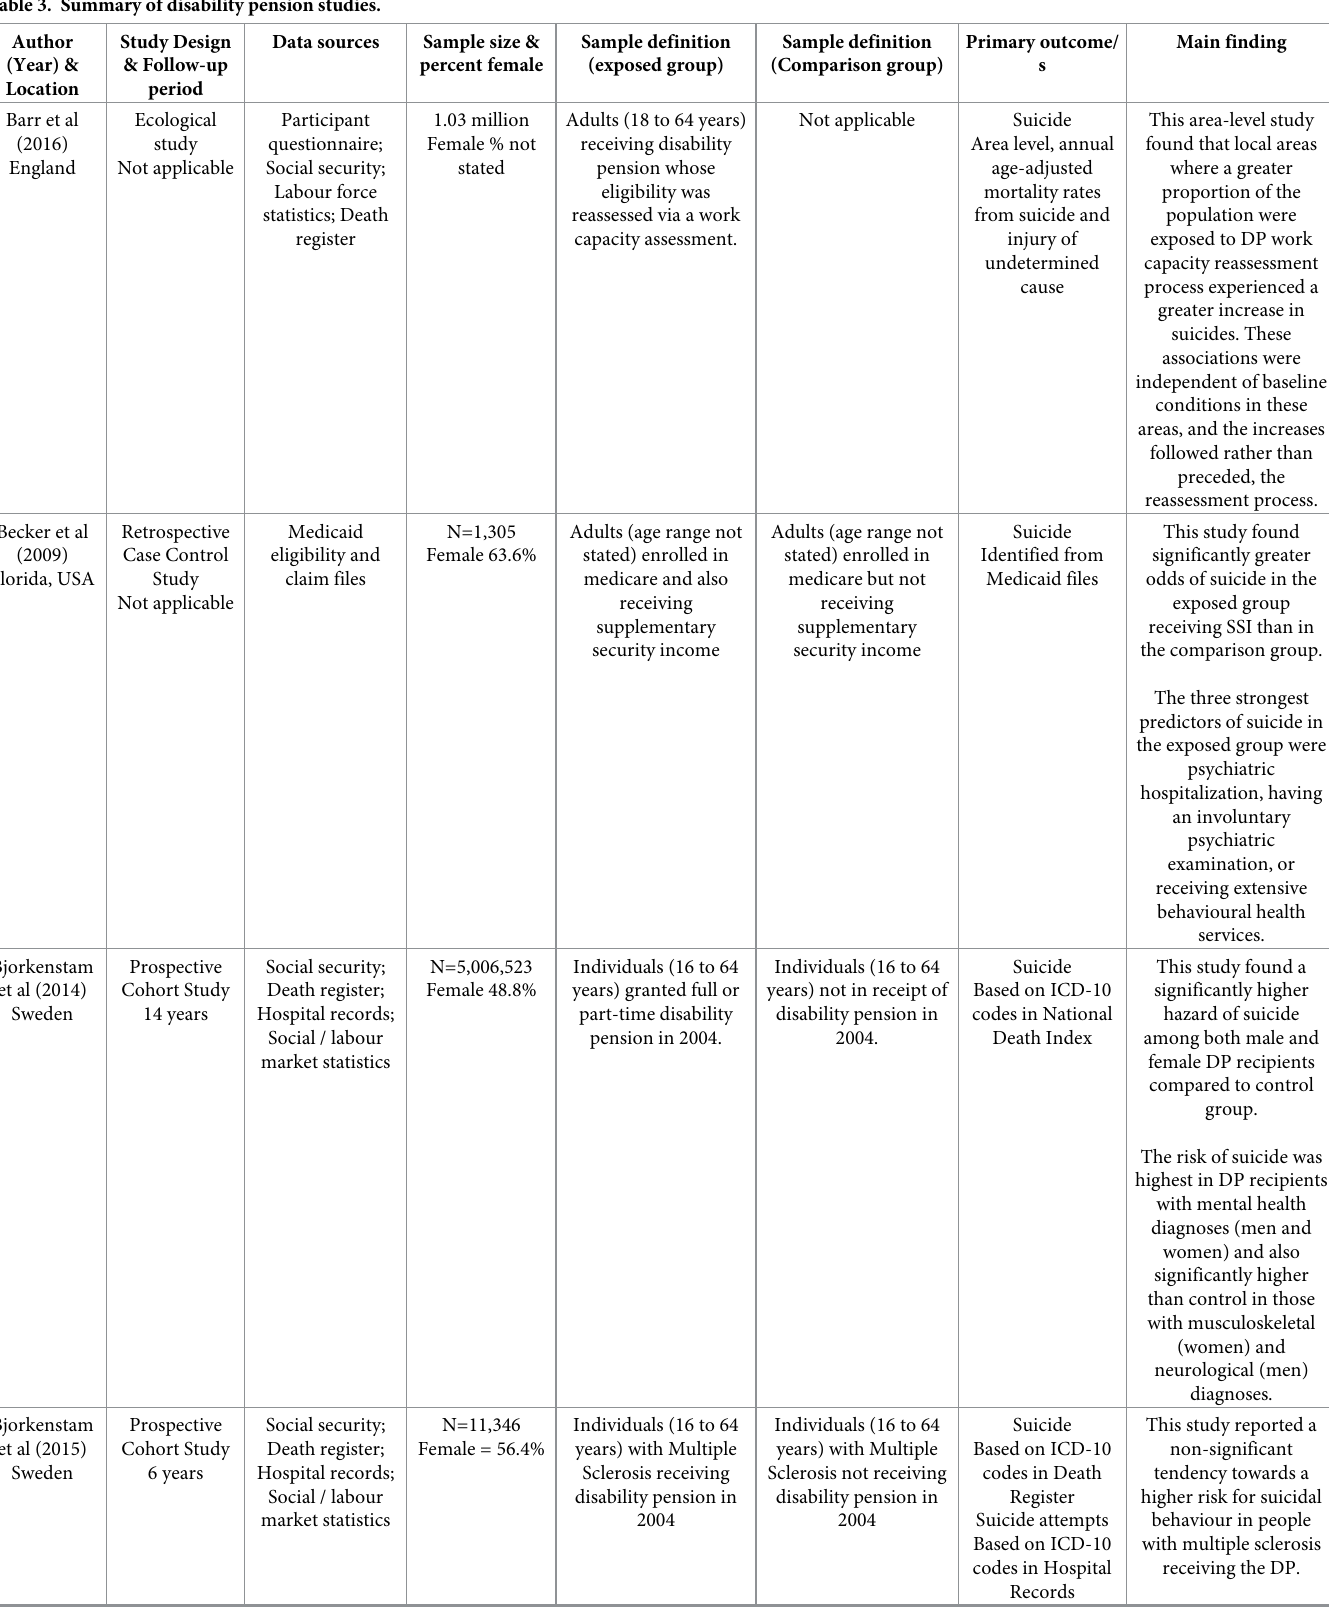
Table 3. Summary of disability pension